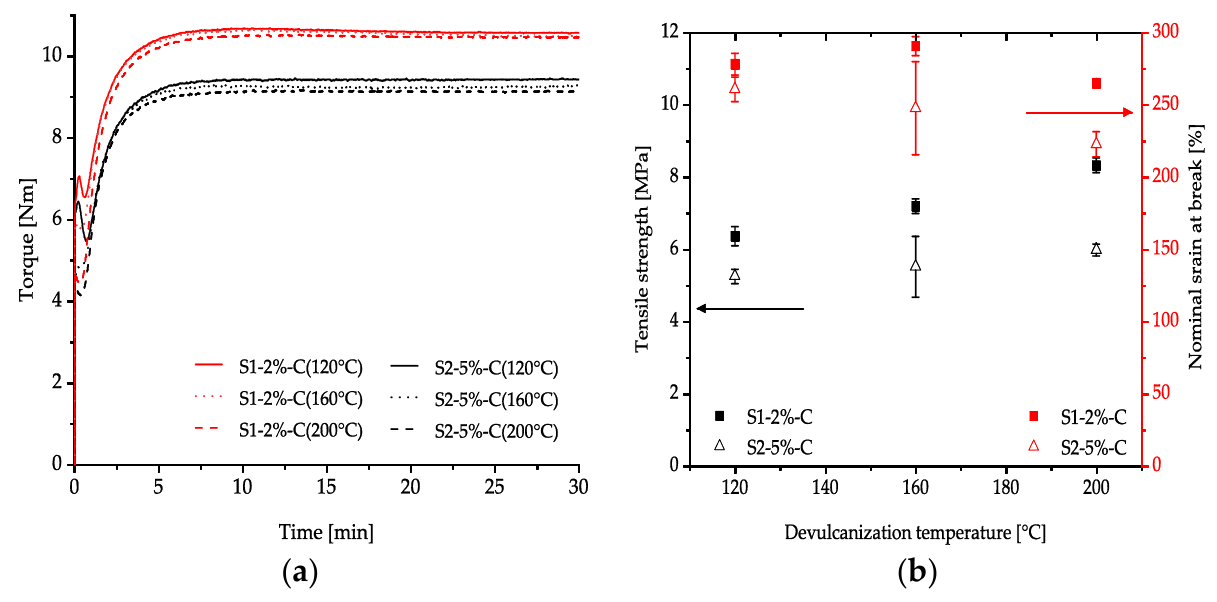
Figure 4. Rheometer curves recorded at 180 °C ( a ), tensile strength (black), and nominal strain at break (red) ( b ) for S1-2%-C ( ∎ ) and S2-5%- C (∆) as a function of devulcanization temperature.